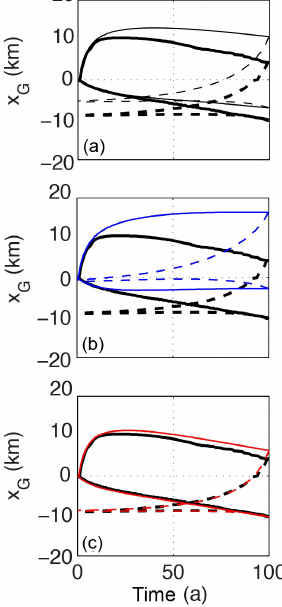
Figure 7. GL evolution on both the symmetry axis (upper curves) and free-slip boundary (lower curves) for the P75S (solid curves) and P75R (dashed curves) comparisons between FELIX-S (bold- black curves) and Elmer/Ice DI ( a , thin black curves), LG ( b , thin blue curves), and FF ( c , thin red curves). The number of elements along the y direction is 40 ( (cid:49)y = 1250m). Note that GL positions are plotted relative to their equilibrium positions in the Stnd exper-